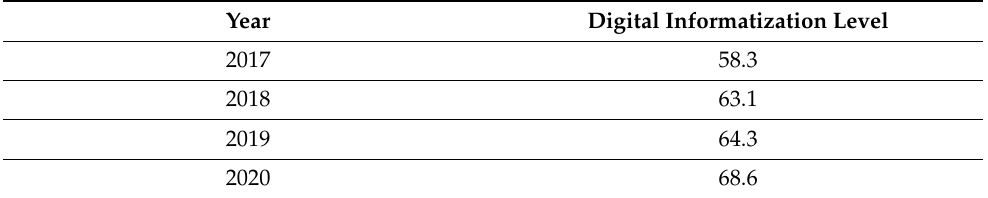
Table 2. Digital Informatization Level of Older People by